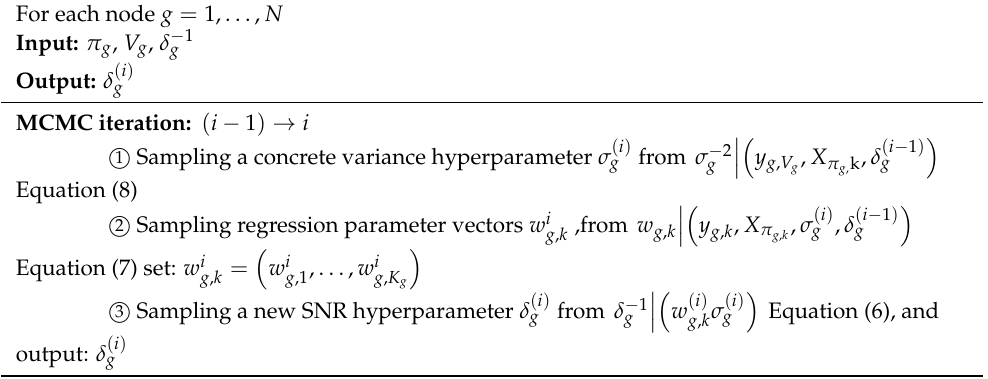
Algorithm 1: Pseudocode for updating the signal-to-noise ratio hyperparameter δ g For each node g = 1, . . . ,